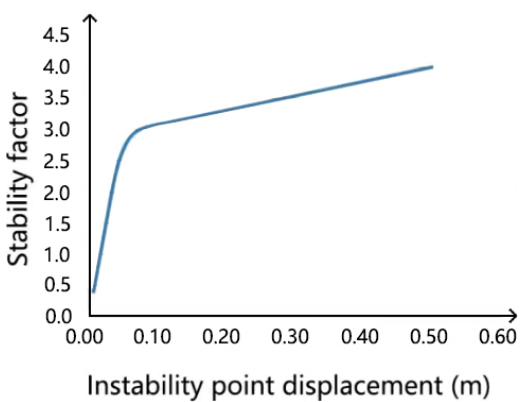
Figure 11. Elastoplastic instability of the roof structure.